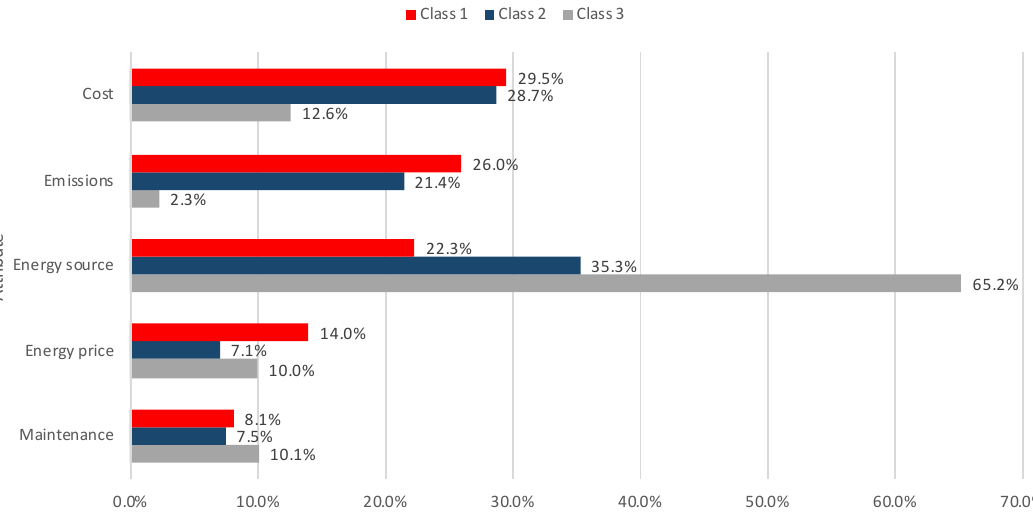
Figure 5. The Latent Class model (LCM)’s estimated relative importance of